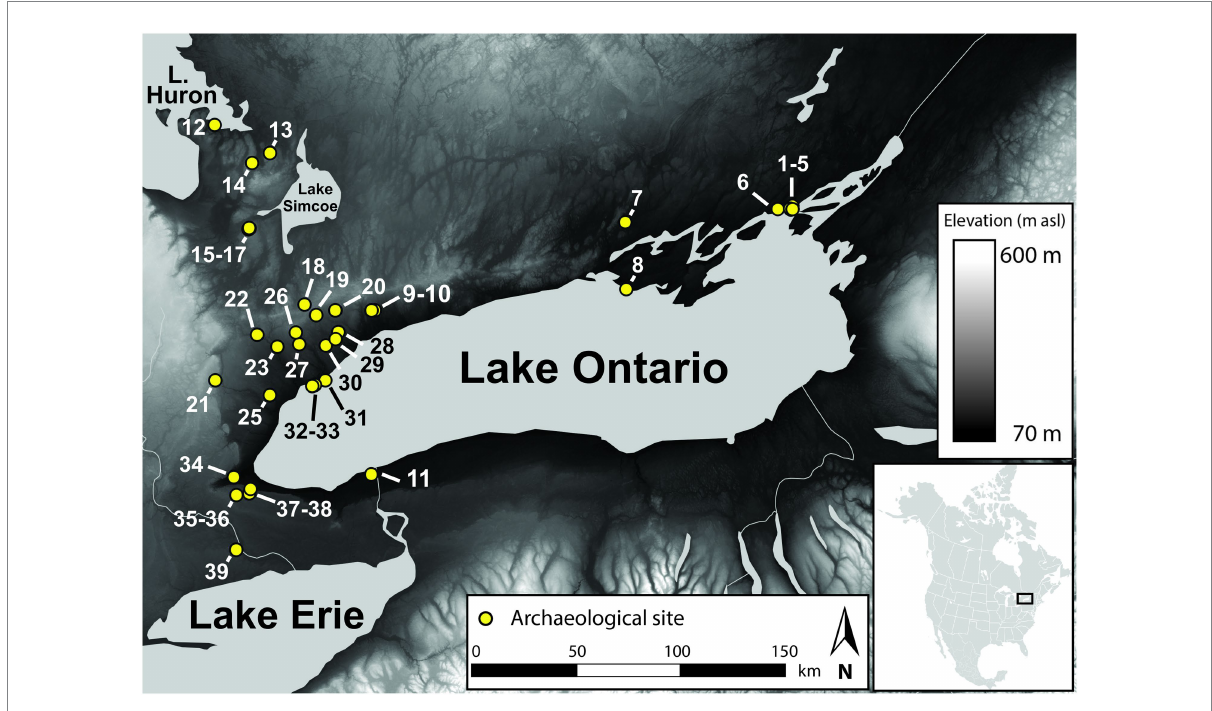
FIGURE 1 Map showing sites and study region. Numbers correspond to site contextual details listed in Supplementary Tables S1;